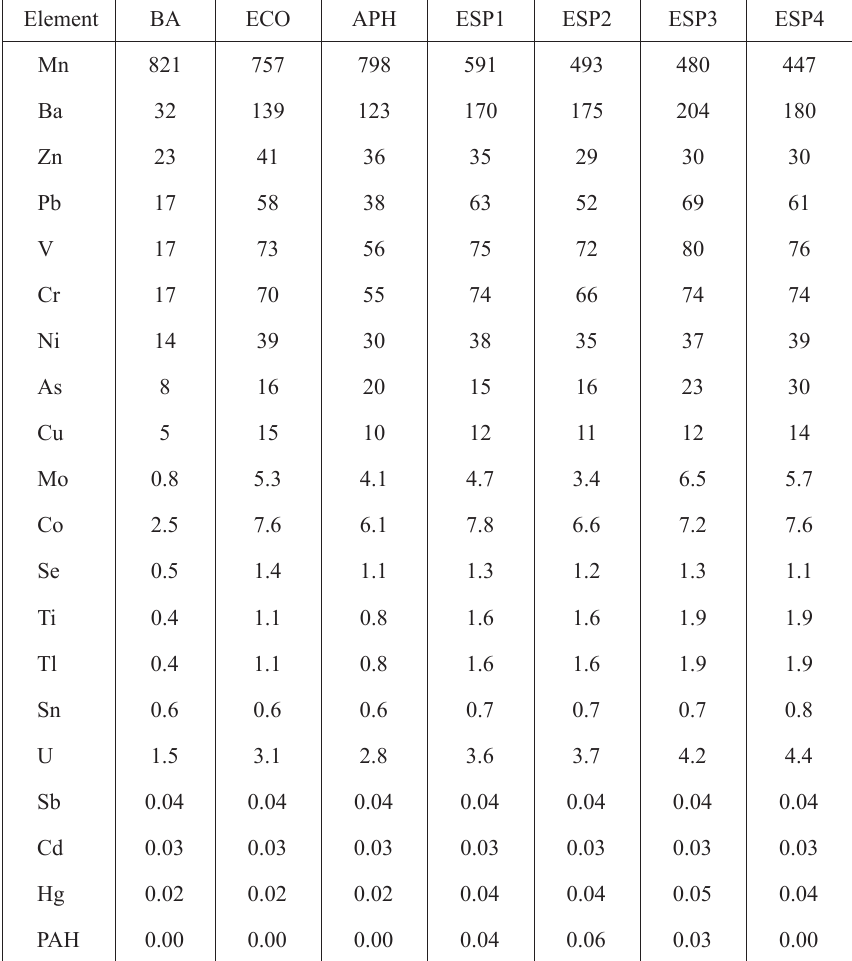
Table 2. Trace element composition of EPP CFBC oil shale ash samples,